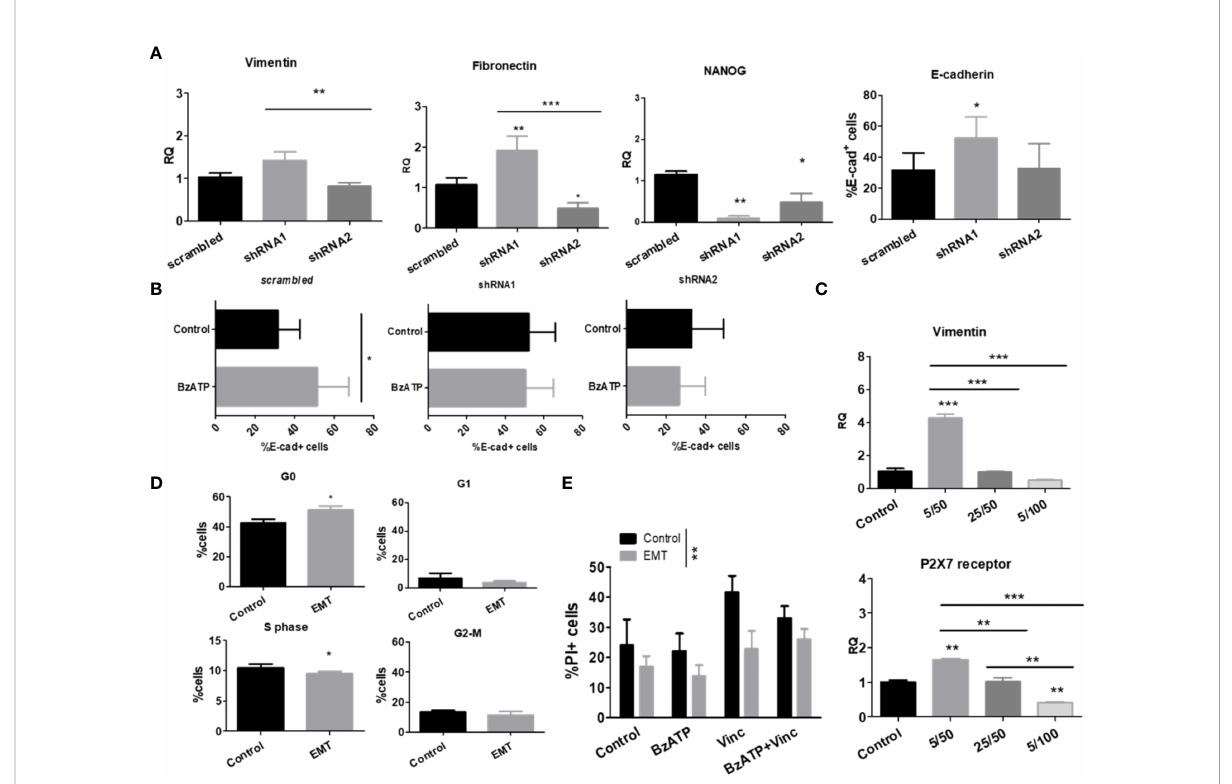
FIGURE 3 P2X7 receptor isoforms in epithelial-mesenchymal transition and stemness of neuroblastoma cells. (A) mRNA expression levels of vimentin, fi bronectin and NANOG (n=3) and protein levels of E-cadherin (n=3) measured in scrambled, shRNA1 and shRNA2 cells. (B) E-cadherin protein levels measured by fl ow cytometry in BzATP-treated vs. nontreated ACN cells (n=3). (C) Vimentin and P2X7 receptor mRNA expression levels in scrambled ACN cells treated with combinations of low/high concentrations of TGF- b (5 or 25 ng/ml) and EGF (50 or 100 ng/ml) (n=3). (D) Cell cycle phase distribution of scrambled ACN cells treated with EMT inducers at optimal concentrations (TGF- b 5 ng/ml + EGF 50 ng/ml) (n=3). (E) Cell death measurements (PI-staining) of scrambled ACN cells treated with the P2X7 receptor agonist BzATP and/or vincristine, with or without treatment with EMT inducers at optimal concentrations (TGF- b 5 ng/ml + EGF 50 ng/ml) (n=3). *p<0.05; **p<0.01;